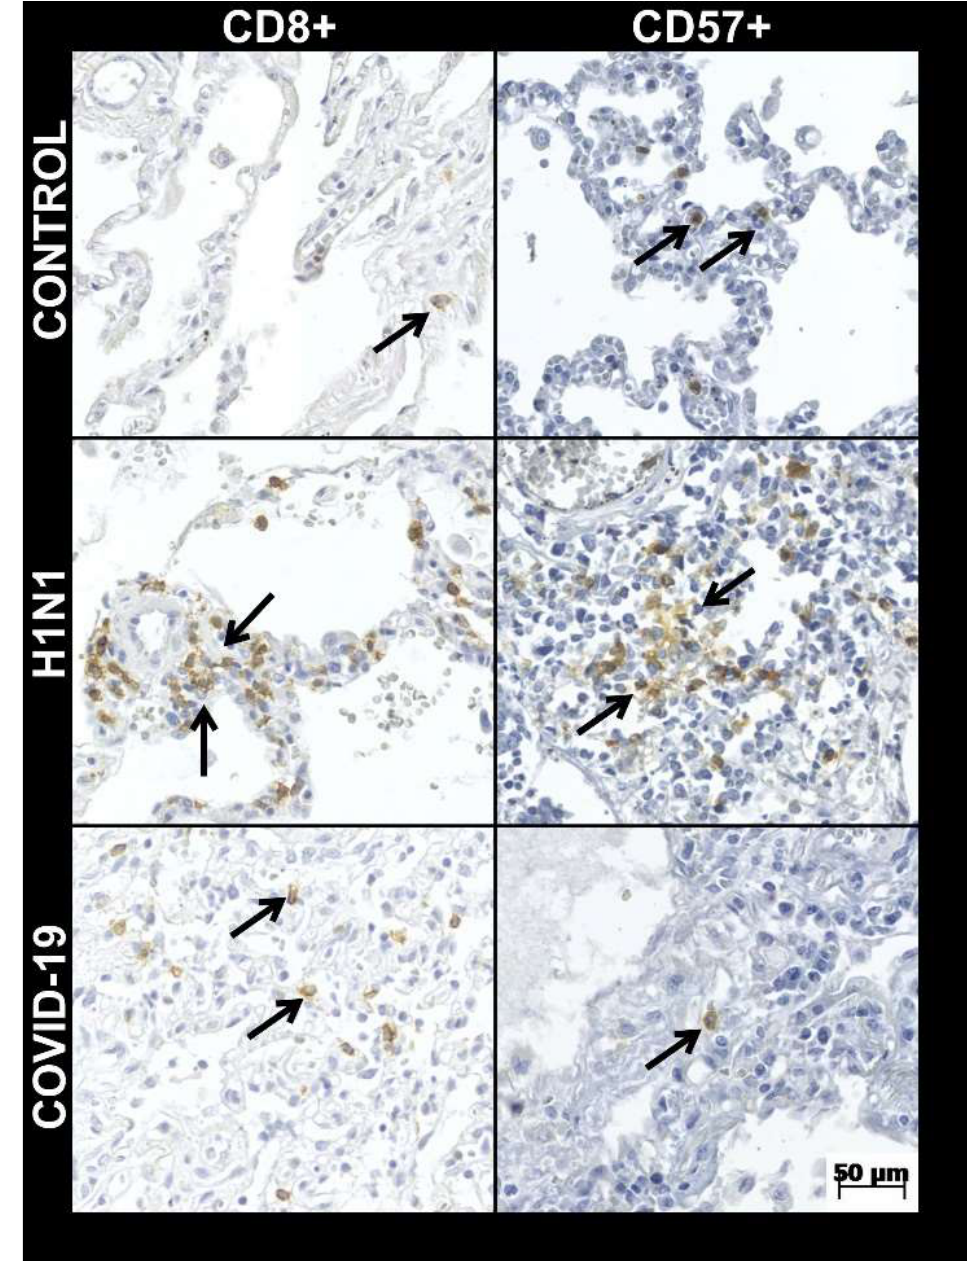
Figure 2. Tissue immunoexpression of CD8+ and CD57+ (number of positive cells per high-power fields—HPF) for COVID-19, H1N1, and CONTROL groups in 40 × HPF (arrows show immunostained cells). Table 1. Baseline characteristics in the study population.